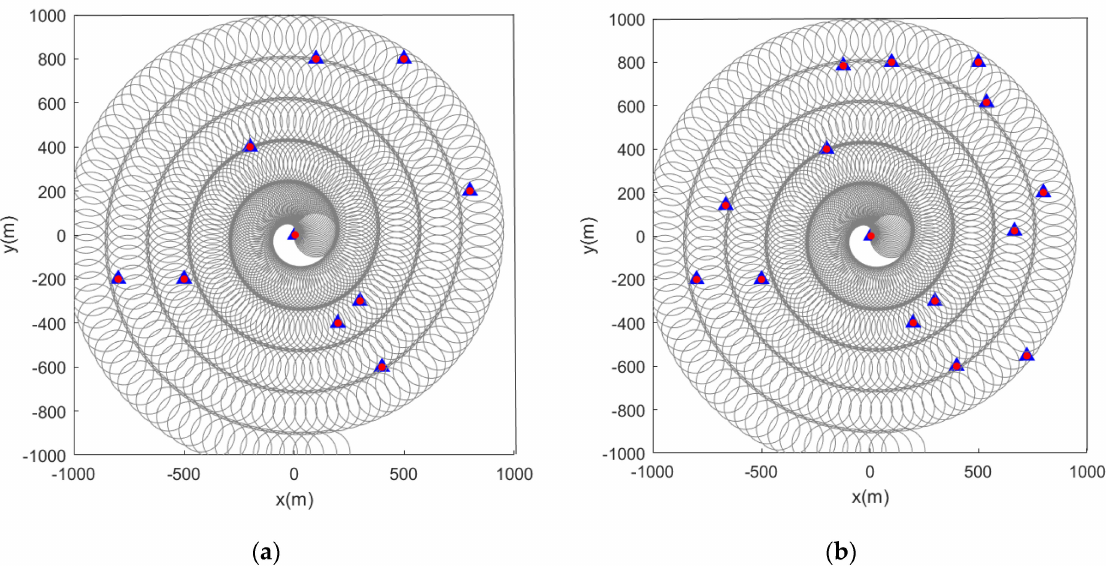
Figure 10. Estimated position of stationary feature points using the LMB algorithm (the red and blue marks indicate the true and estimated positions, respectively, of the feature points in the scene). ( a ) Sensor detection radius is 100 m and there are 10 feature points in the scene; ( b ) sensor detection radius is 100 m and there are 15 feature points in the scene.